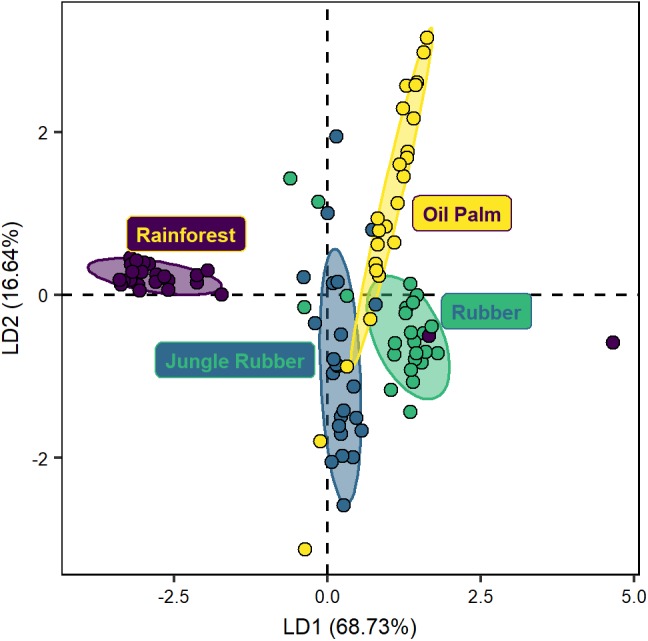
Discriminant function analysis of protist communities of four land-use systems (rainforest, jungle rubber, rubber plantation and oil palm plantation; Wilks’ λ = 0.12, F12,235 = 23.5, p < 0.001) based on quality-filtered data. Eigenvalues: LD1 = 0.60, LD2 = 0.25. Ellipses drawn for better visualization of the respective land-use systems include 75% of the respective plots.